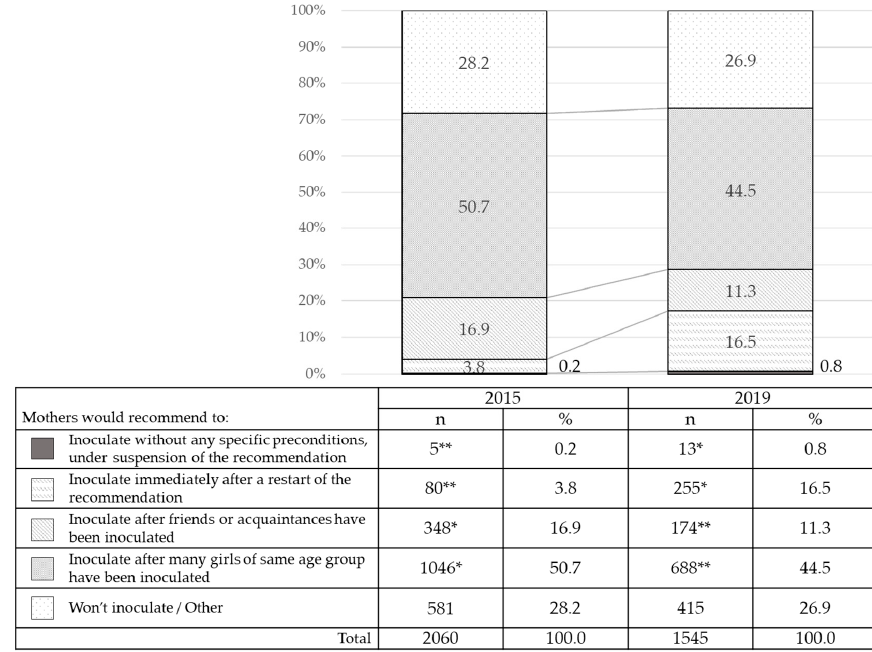
Figure 3. Changes over time in the preconditions mothers would require before allowing their daughters’ Human Papillomavirus (HPV)